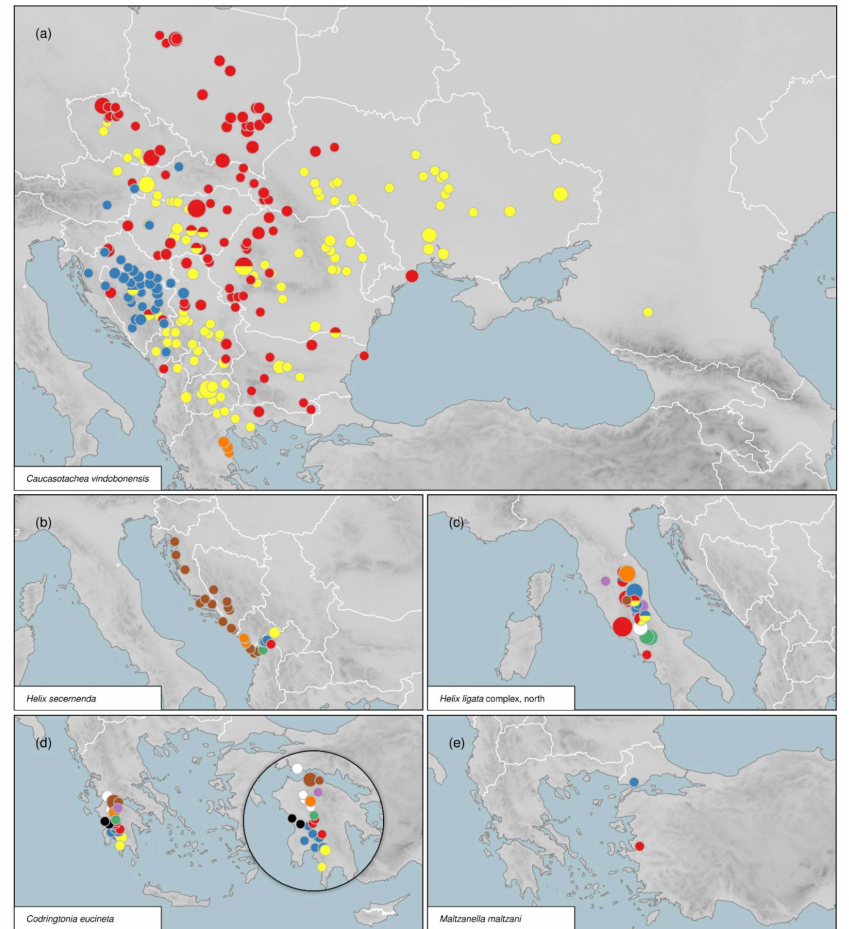
Figure 6. Examples of different patterns in distribution of intraspecific mitochondrial lineages: ( a ) large distribution ranges, a spatially restricted lineage in a southern refugium and marked differ- ences in lineage frequencies between a glacial refugium in Bosnia and Montenegro and other parts of the range in Caucasotachea vindobonensis ; ( b ) number of spatially restricted lineages, some of them limited to high latitudes, along with a recent expansion of one clade in Helix secernenda ; ( c ) high number of lineages overlapping in distribution in the northern clade of the Helix ligata complex in the Apennine Peninsula; ( d ) similarly high but geographically arranged diversity in Codringtonia eucineta ; ( e ) two spatially isolated lineages in the clade of Maltzanella maltzani , which is known from these two restricted disjunct areas only. For other maps and the underlying phylogenies, see Figures